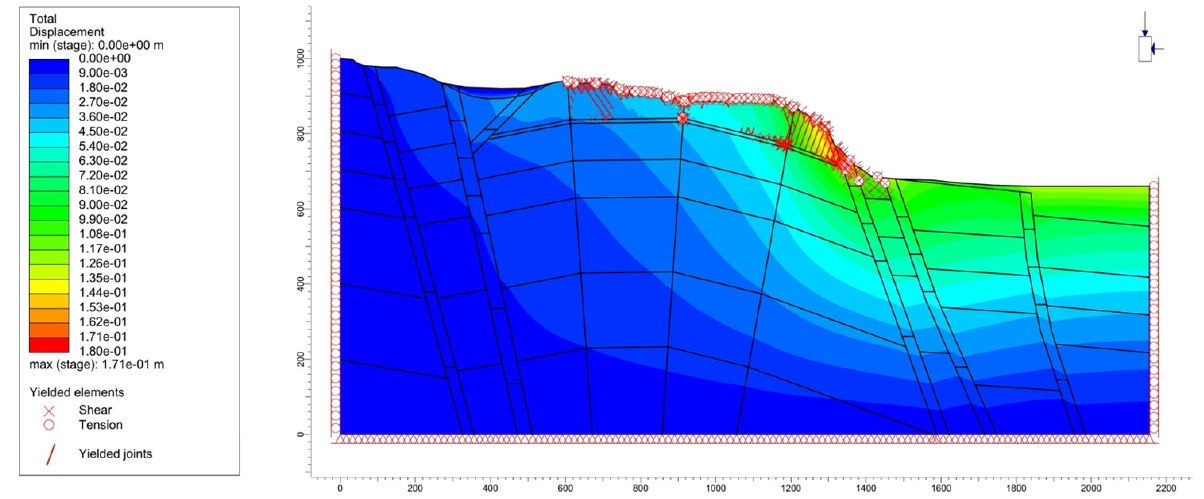
Figure 10. Total displacement and yielded nodes/joints in the present conditions, after all unloading stages and creep evolution. x -axis is in meters, while y -axis is in meters